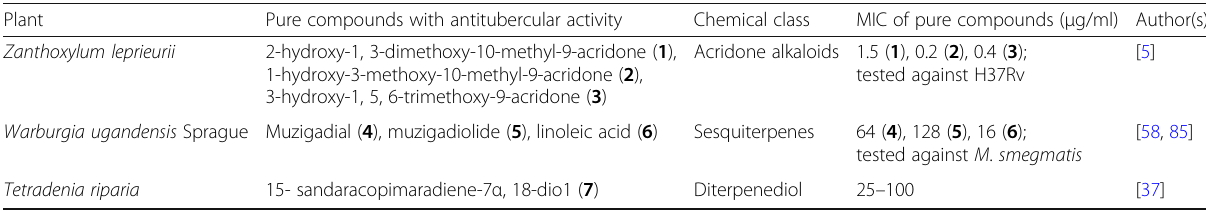
MIC minimum inhibitory concentration. No toxicity studies of the pure compounds were